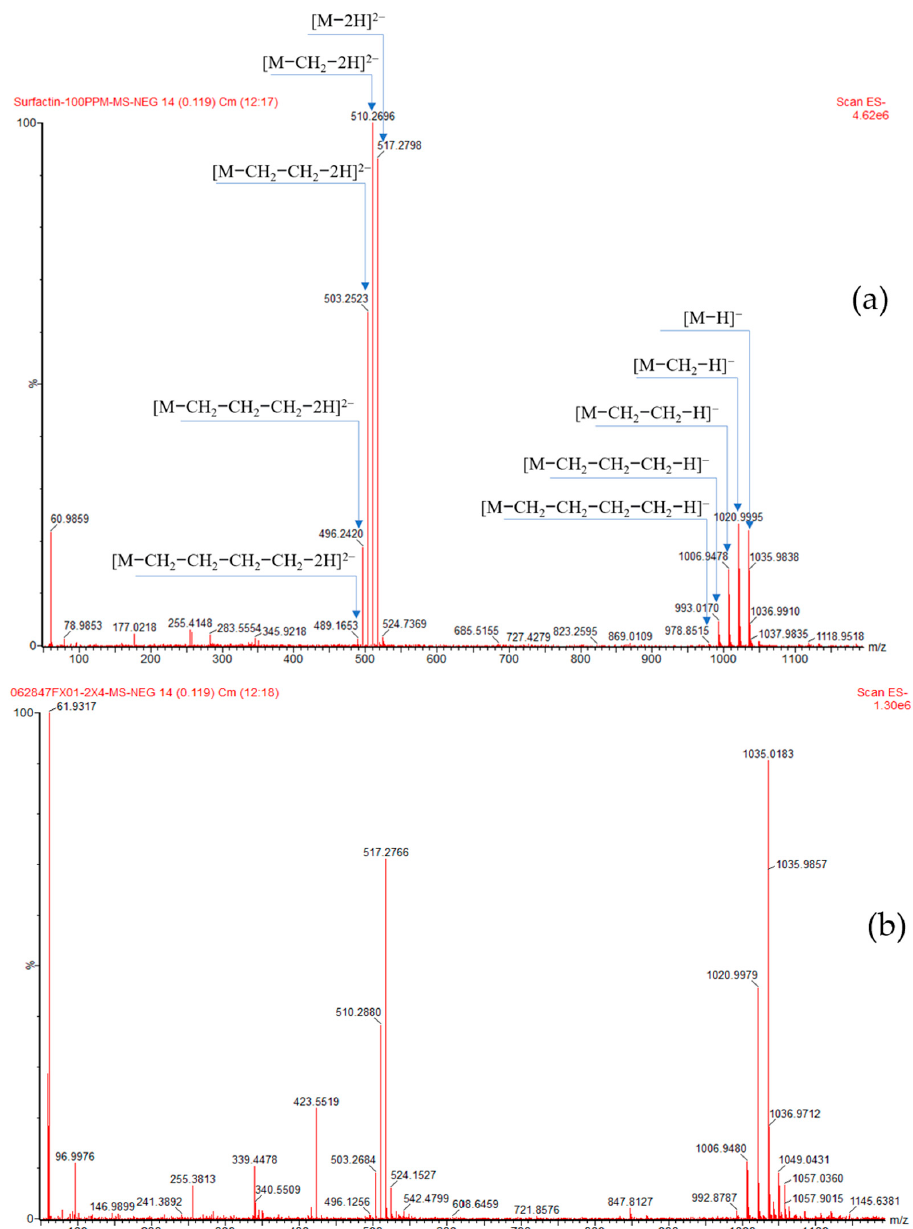
Figure 5. ( a ) Surfactin standard sample ESI-MS. ( b ) Biosurfactant production ESI-MS.